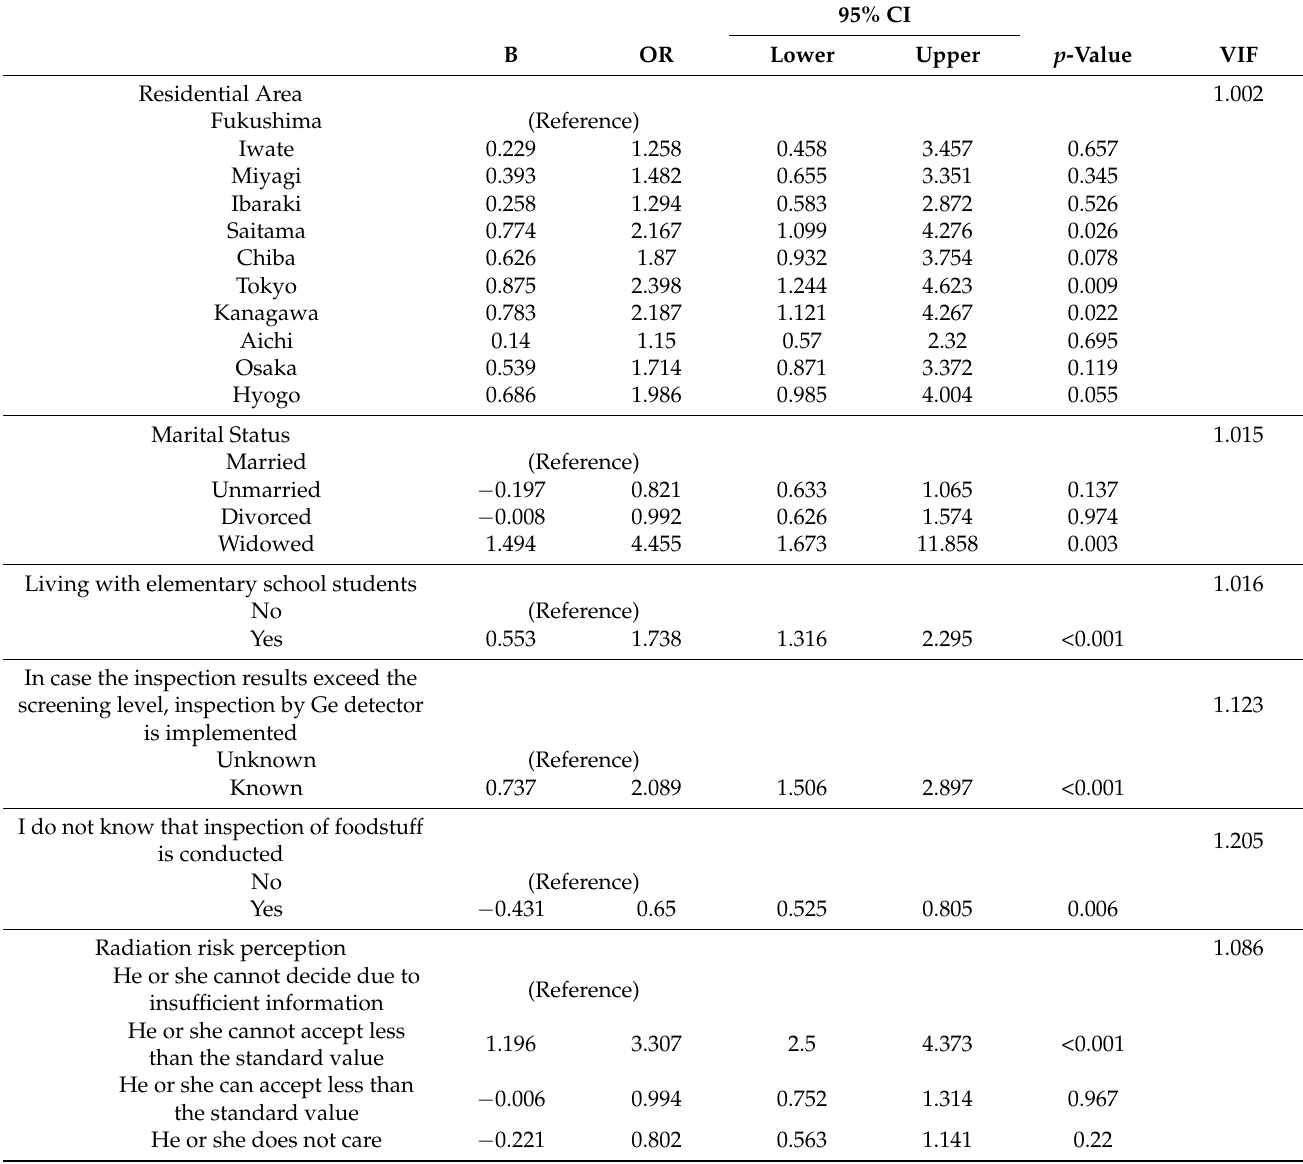
Table 4. Logistic regression analysis of refraining from purchasing foods produced in affected areas to avoid radioactive materials in the 14th